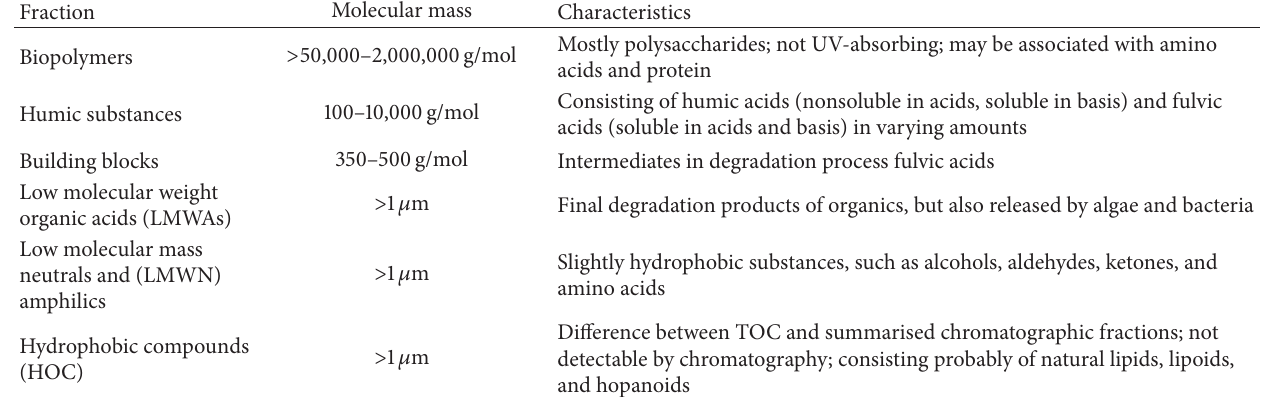
Table 1: Characteristic NOM fractions of surface water described by the LC-OCD technique [4, 17].